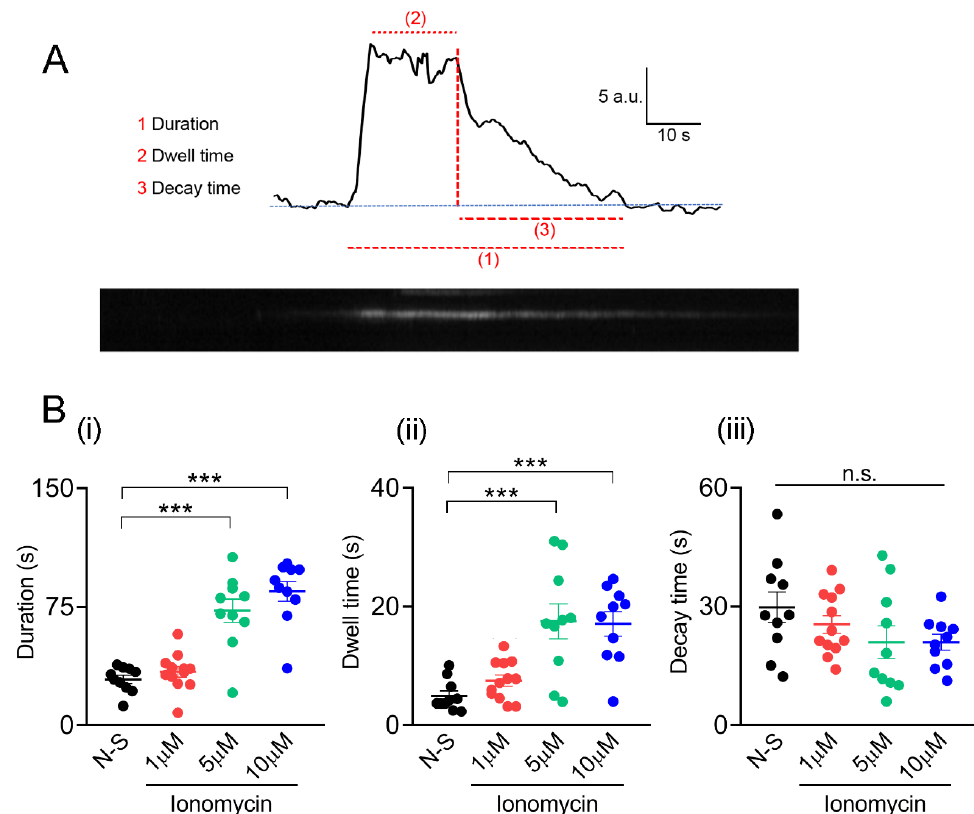
Figure 2. Kinetic parameters of spontaneous and ionomycin-induced pHluorin signals in C25 myoblasts. ( A ): An example of a trace of a transient fusion event induced in C25 myoblasts stimulated with 10 µ M ionomycin ( top ) and its corresponding kymograph ( bottom ). The parameters analyzed were: (1) duration, (2) dwell time and (3) decay time. ( B ): A summary of these three parameters (( i ), ( ii ) and ( iii ), respectively), obtained from pHluorin signals induced in non-stimulated (N-S; 10 cells) or stimulated C25 myoblasts with 1, 5, or 10 µ M ionomycin (12, 10, and 10 cells, respectively), are represented. Dots represent values from individual cells from at least three independent cultures. Horizontal lines indicate means with SEM. N. *** p < 0.001, n.s. (non-significant difference)